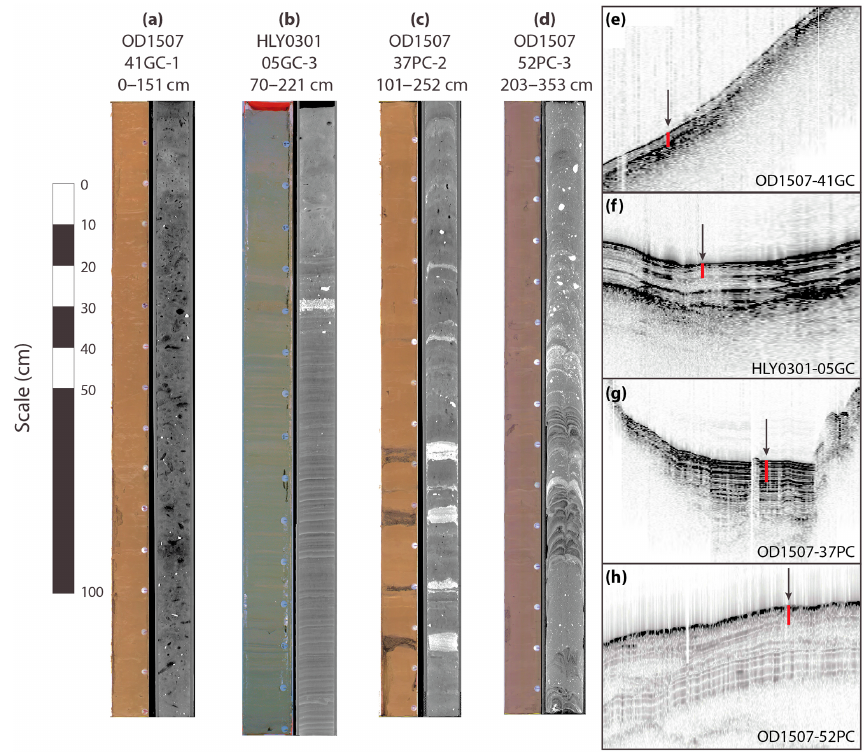
Figure 6. Correlation of core lithofacies with seismo-acoustic Facies III (a, b, e, f) , IV (c, g) and V (d, h) . Core lithofacies are shown using CT scans (dark: lower density; light: higher density) and core photographs; seismo-acoustic facies at each core site are shown in panels (e) – (h) . Note the coring artefact in core OD1507-52PC with layers bent down at the sides. The red bars in panels (e) – (h) represent the total core length for each core (using a velocity through sediment of 1500ms − 1 ); core locations are shown on Fig.